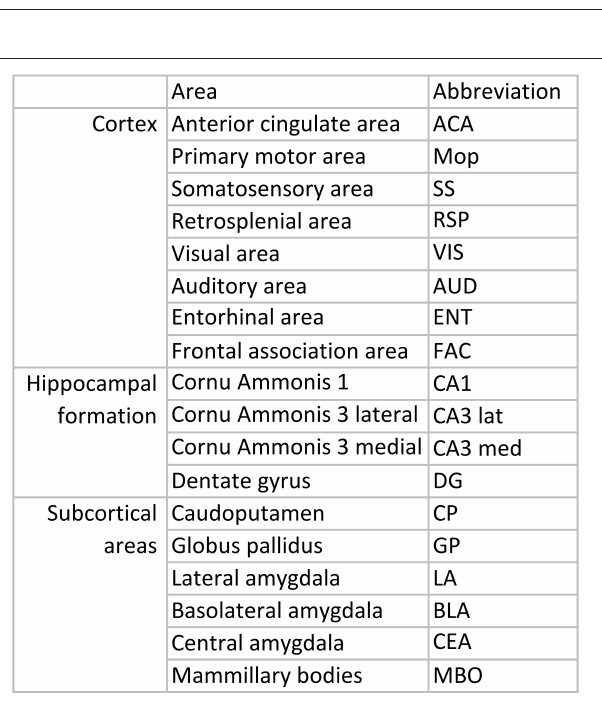
FIGURE 2 | Oligonucleotide DNA probes.